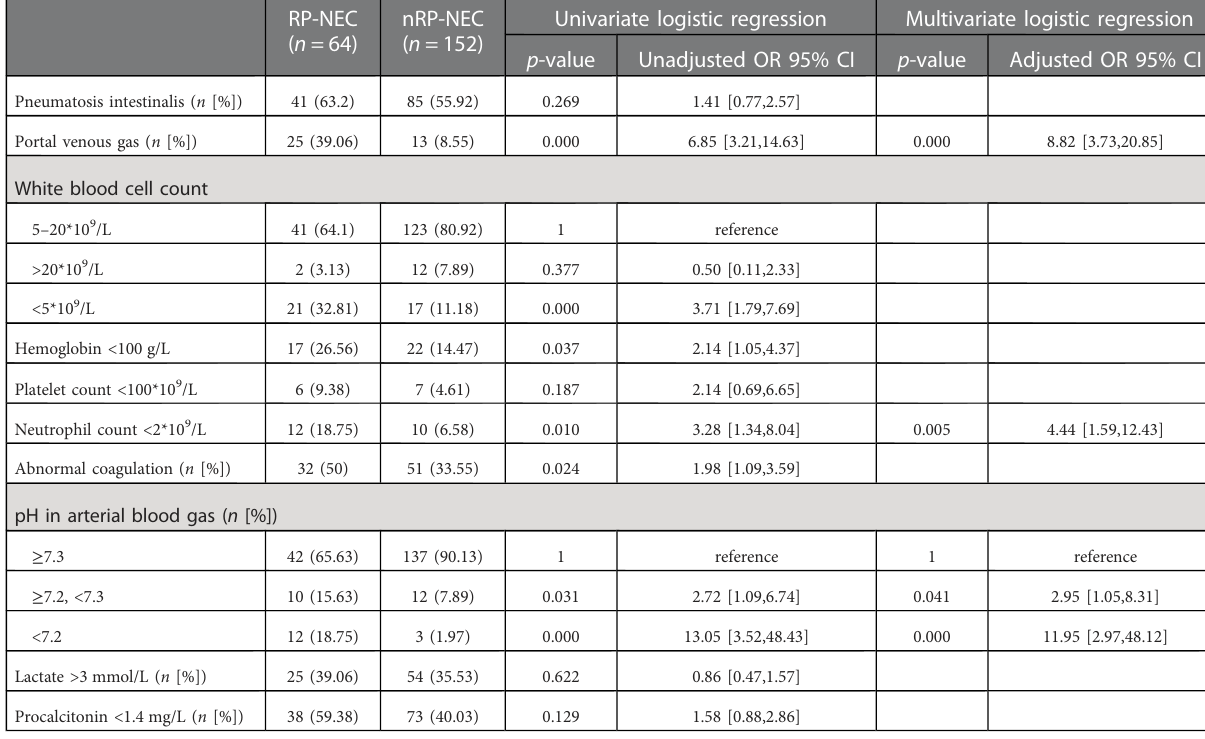
TABLE 3 Univariate and multivariate logistic regression analyses for radiographic fi ndings and laboratory variables at disease onset of RP- and nRP-